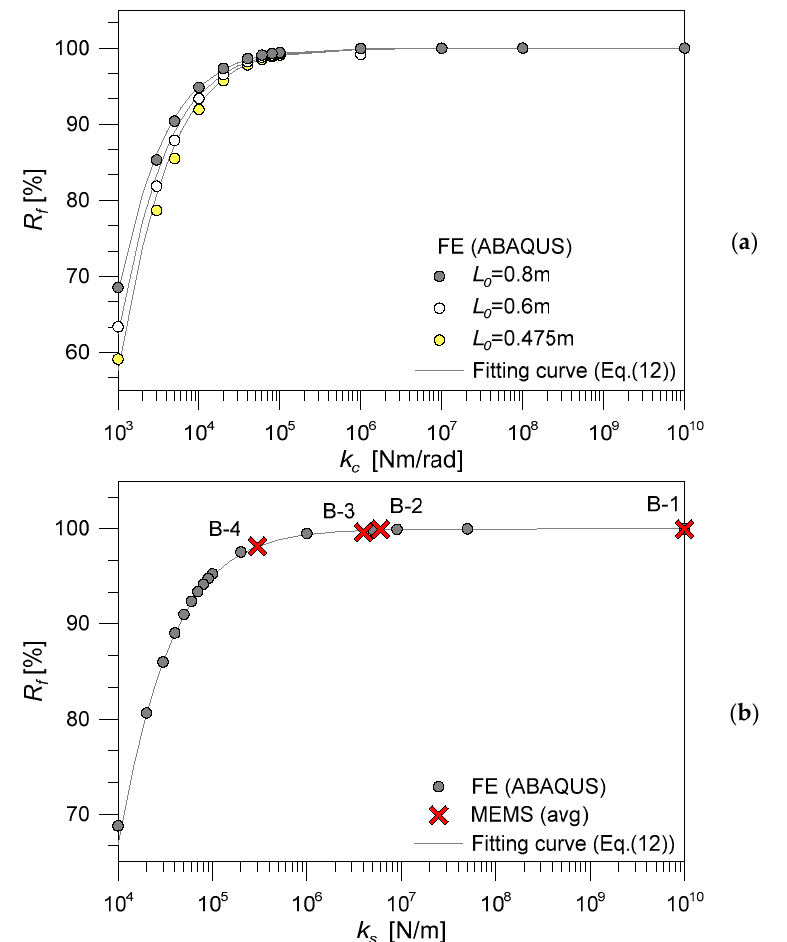
Figure 8. Fundamental frequency variation for ( a ) cantilever (C-type) and ( b ) beam (B-type) glass specimens, as a function of the rotational ( k c ) and axial ( k s ) stiffness of restraints.